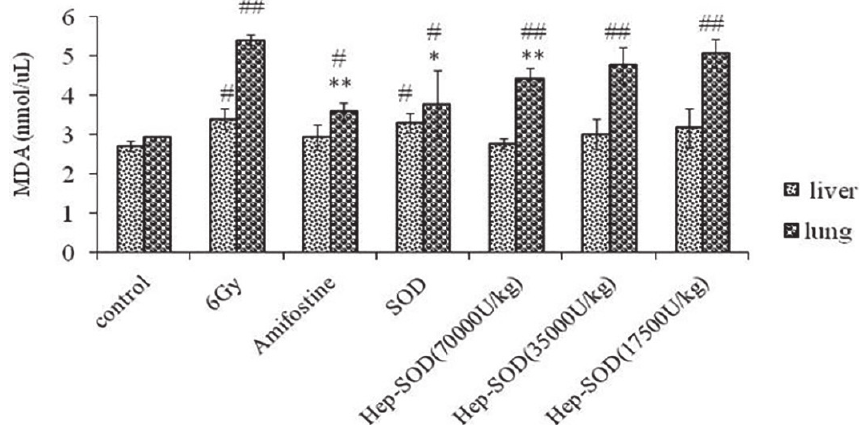
FIGURE 2 – MDA content in the liver and lung of irradiated mice in different groups. Notes: MDA content of 56 mice in different groups was detected, with eight mice in each group. * P < 0.05, ** P < 0.01, compared with the irradiated control group. # P < 0.05, ## P < 0.01 compared with the normal control